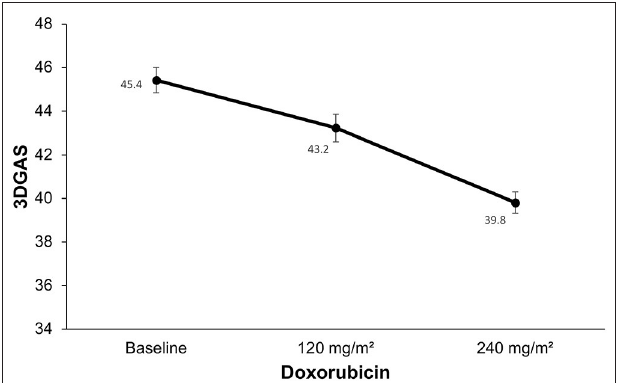
FIGURE 4 | Changes in global area strain derived from the three-dimensional speckle tracking echocardiography. Compared to baseline there was a decrease in three-dimensional global area strain (3DGAS) after a lower cumulative dose of doxorubicin (120 mg/m 2 ; p < 0.001). There was a decrease in 3DGAS after 240 mg/m 2 dose of doxorubicin compared to baseline ( p <